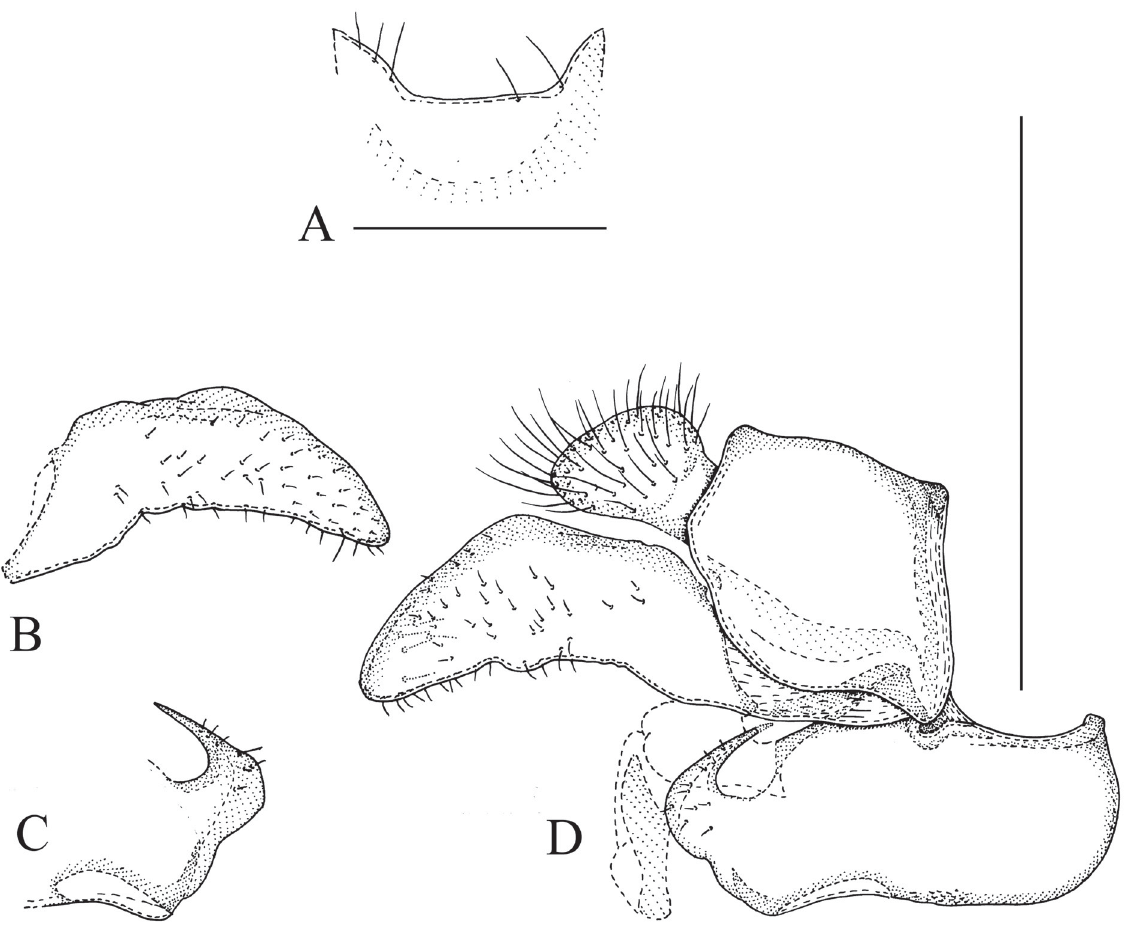
Fig. 4. Spheg ina (Sphegina) angustata sp. nov., holotype, ♂ . A . Posterior part of sternum IV, ventral view. B . Left surstylus, lateral view. C . Left superior lobe, lateral view. D . Genitalia, right side, lateral view. Scale bars = 0.5